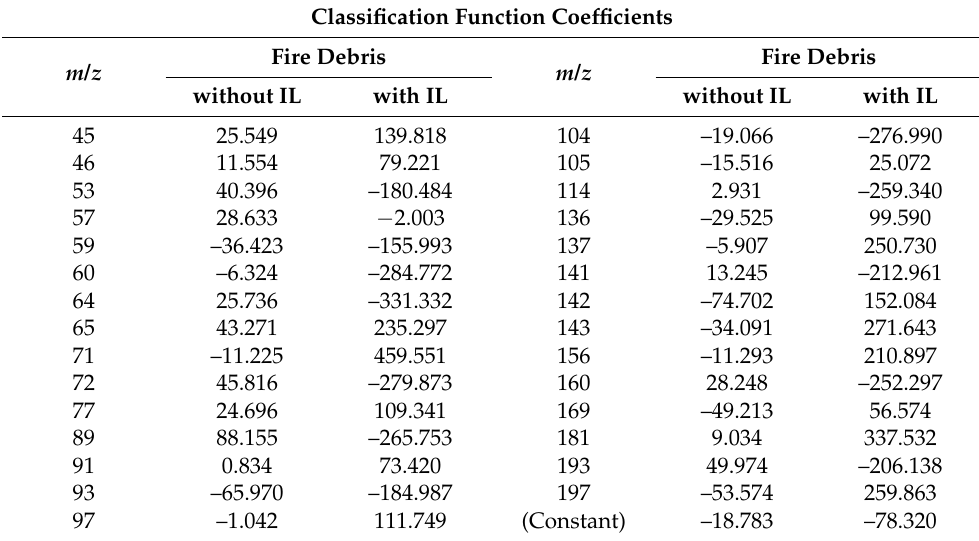
Table 1. Fisher´s linear discrimination functions for fire debris samples burned with/without IL obtained from the linear discriminant analysis (LDA).